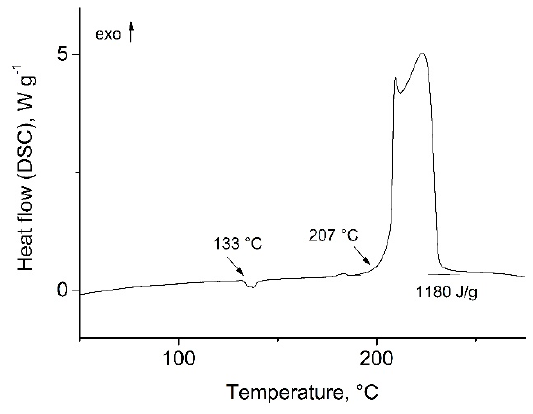
Figure 3. DSC curve for compound 3 . Table 1. Comparison of physicochemical parameters of the compound 3 with known energetic materials.